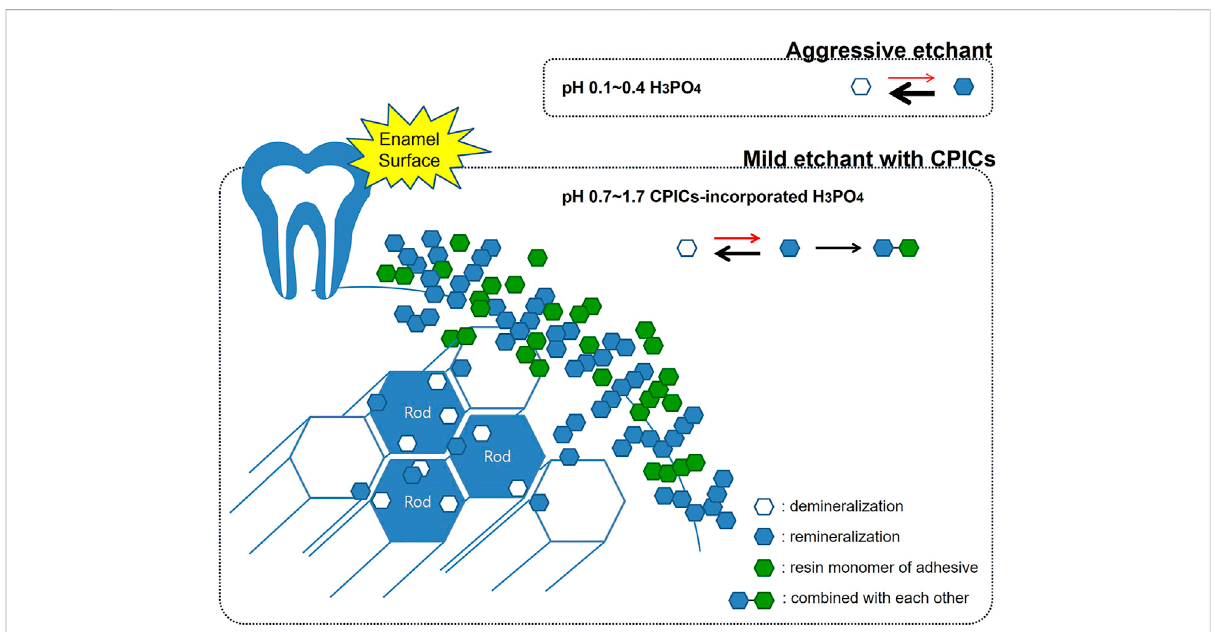
FIGURE 14 Schematic representation showing enamel remineralization induced by the calcium phosphate ion clusters-incorporated phosphoric acid solution. Using a Ca – P buffering to create a less aggressive etchant not only protects the enamel but also lowers enamel demineralization. The crystals generated by the remineralization of Ca – P were found to combine with the adhesive to improve the bonding strength and protect the enamel when the bracket is removed.